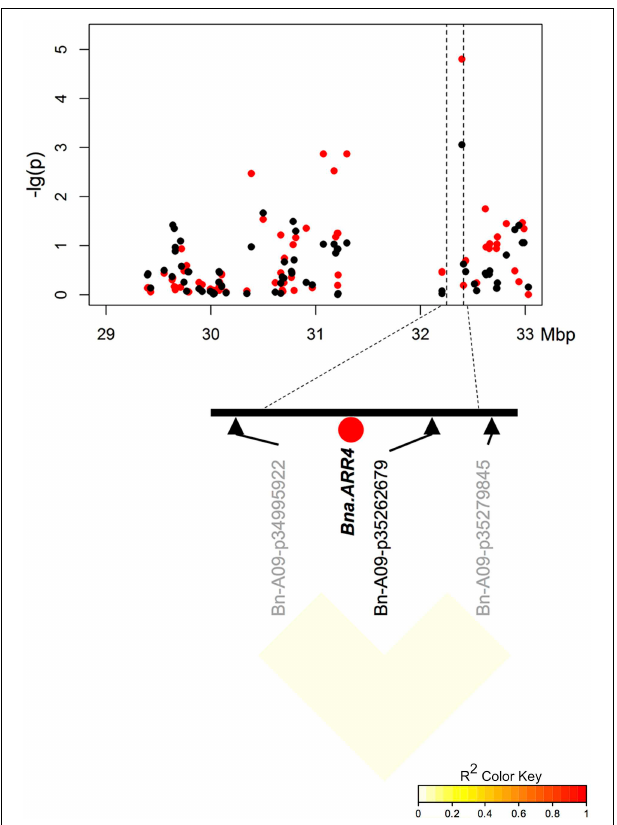
FIGURE 4 | Manhattan plot describing marker-trait associations for the trait ES within the chromosomal region around candidate BnaA09g48160D (Bna.ARR4) on chromosome A9, and correlations between surrounding markers. Red dots represent associations calculated for SL2011. Black dots represent associations for